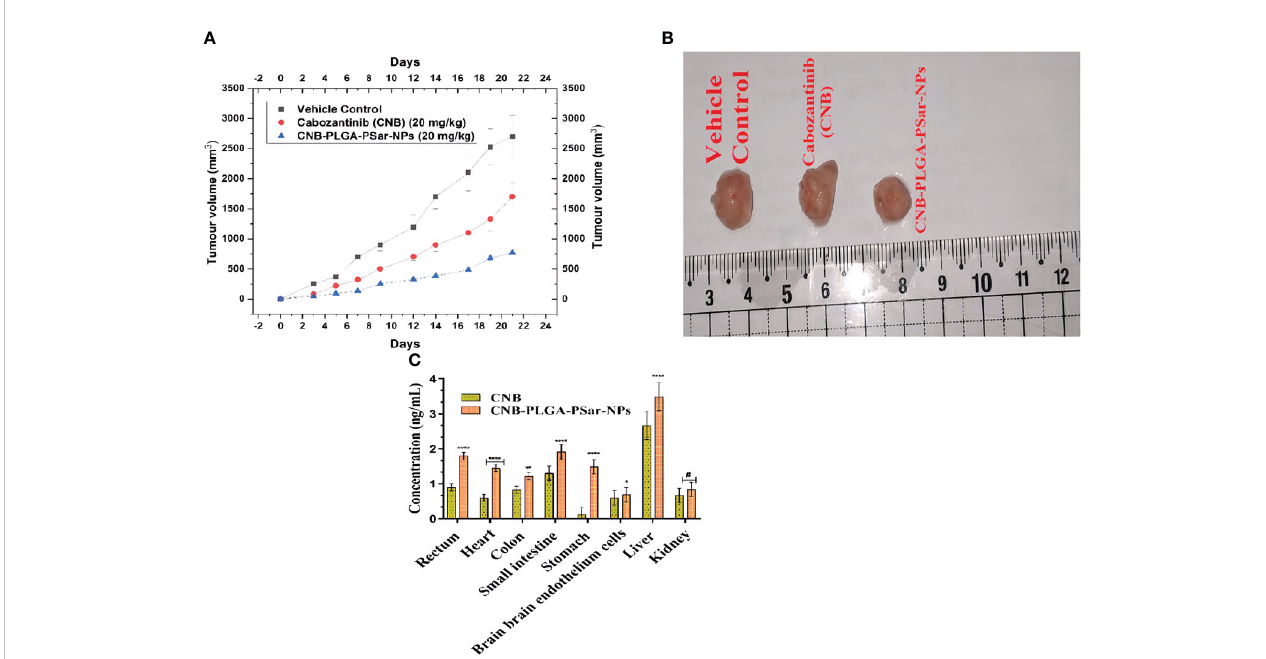
FIGURE 9 (A) Tumor regression study in HePG2 cells Xenograft model showing changes in relative tumour volume with time (days) of different groups of SCID (severe combined immunode fi ciency disorder) mice (n=6) treated with Cabozantinib (CNB), CNB-PLGA-PSar-NPs. equivalent concentration 20 mg/kg, I.V.) (B) Isolation of tumours after 21 days of studies (C) Comparative in vivo biodistribution of Cabozantinib (CNB), CNB-PLGA-PSar-NPs in rectum, heart, colon, small intestine, stomach, brain endothelium, liver, and kidney after i.v. administration of 20 mg/kg. i.v. bolus dose; values are represented as mean± SD (n=6) (****) highly signi fi cance; p<0.00001, (***) moderately signi fi cance<0.0001, (**)partial signi fi cance; p<0.001, (*) less signi fi cance< 0.05, (#) statistically non-signi fi cance difference from CNB (p>0.05; all the formulations were compared against controlled